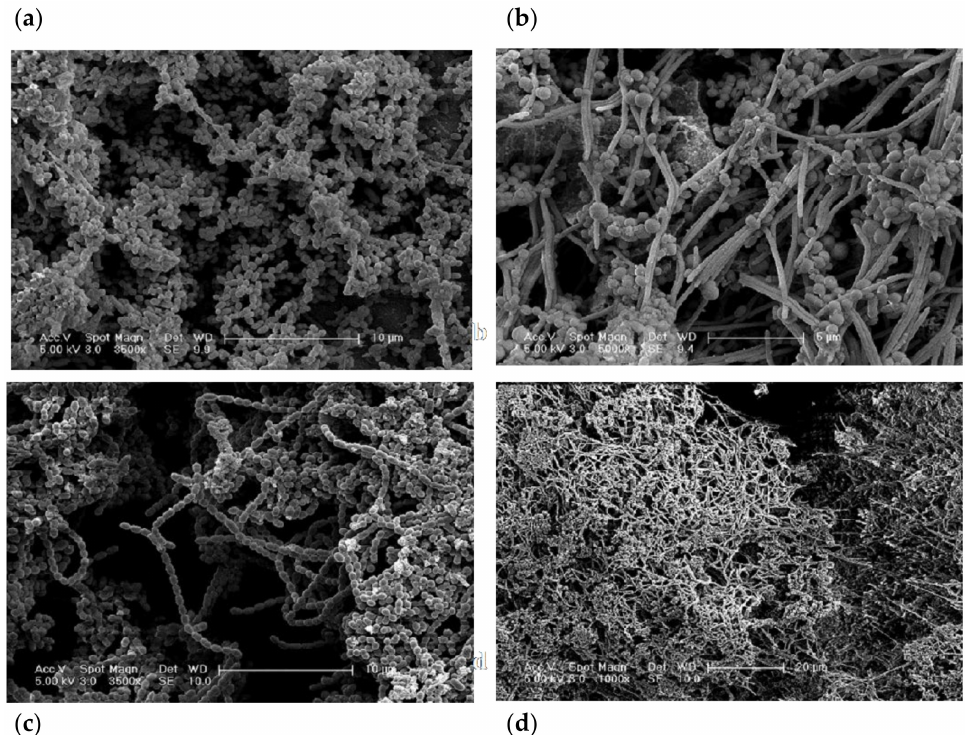
Figure 3. Scanning electron microscopy images showing microcosm biofilms from a CDFF 30-day peri-implantitis model. Biofilms were grown on machined Ti and sampled throughout the study period. ( a ) Represents 4-day-old biofilm grown under conditions emulating health (scale bar = 10 µ m, magnification 3500 × ). ( b , c ) Represents 9- ( b ) (scale bar = 5 µ m, magnification 5000 × ) and 15-day ( c ) biofilms after the induction of peri-implant mucositis conditions (scale bar = 10 µ m, magnification 3500 × ). ( d ) Represents a 30-day biofilm under peri-implantitis conditions (scale bar = 20 µ m, magnification 1000 × ).